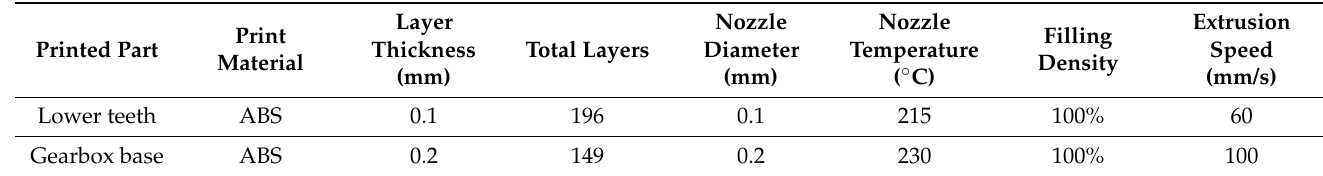
Figure 8. The printed gearbox base.